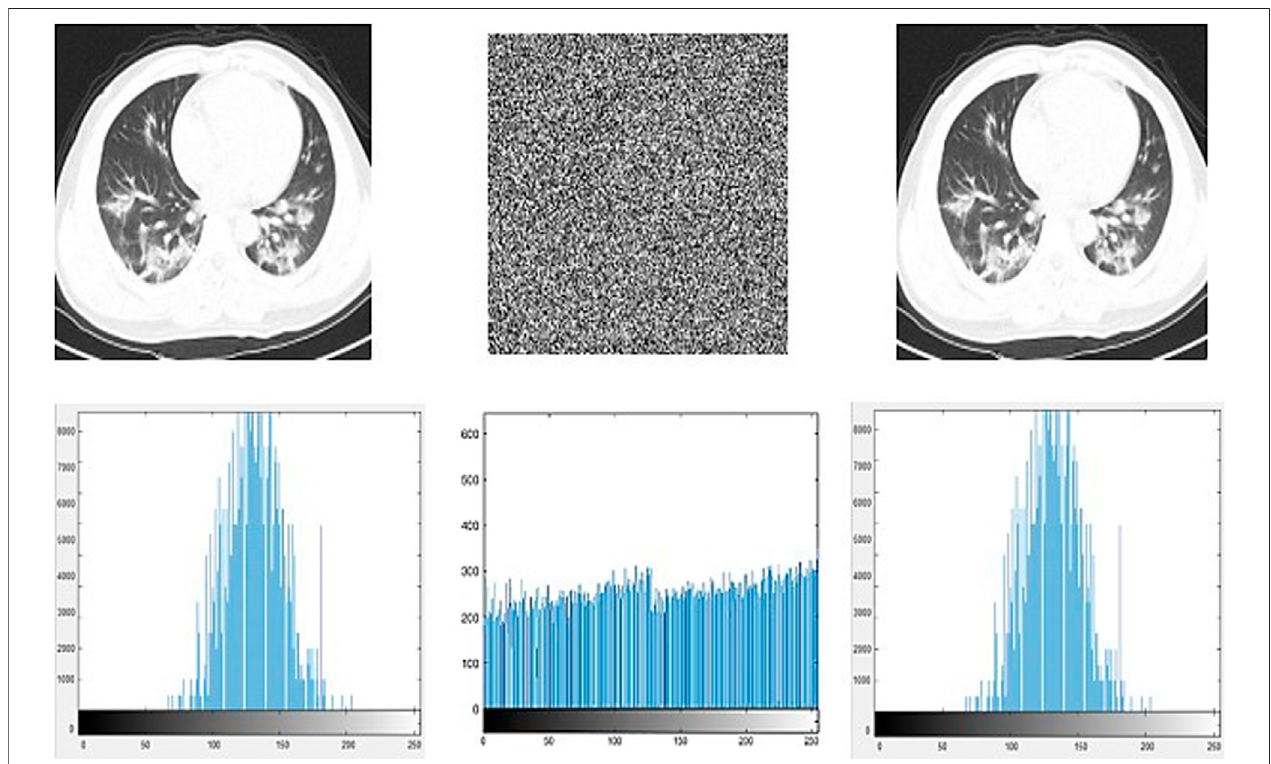
FIGURE 5 | Applying the proposed double encryption and decryption on a lung image.